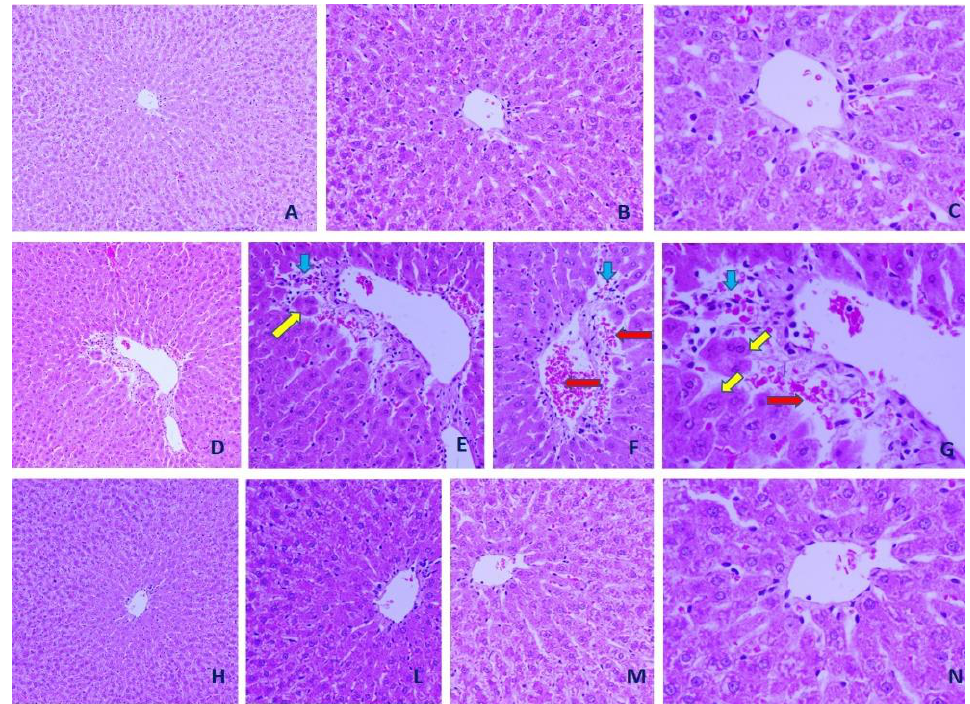
Figure 6. Representative microscopic images from control, CCl 4 and CCl 4 + selenium nanoparticles (SE-NPs) hepatic tissues. ( A – C ): Control hepatic tissues ( × 200, × 400, and × 1000, respectively). ( D – G ) CCl 4 hepatic tissues ( × 200, × 400, × 400, and × 1000, respectively). ( H – N ) CCl 4 + SE-NPs hepatic tissues ( × 200, × 400, × 400, and × 1000, respectively). Hepatocytes (yellow arrows), inflammatory cells (blue arrows) and hemorrhage (red arrow) are shown (hematoxylin–eosin (H&E)).